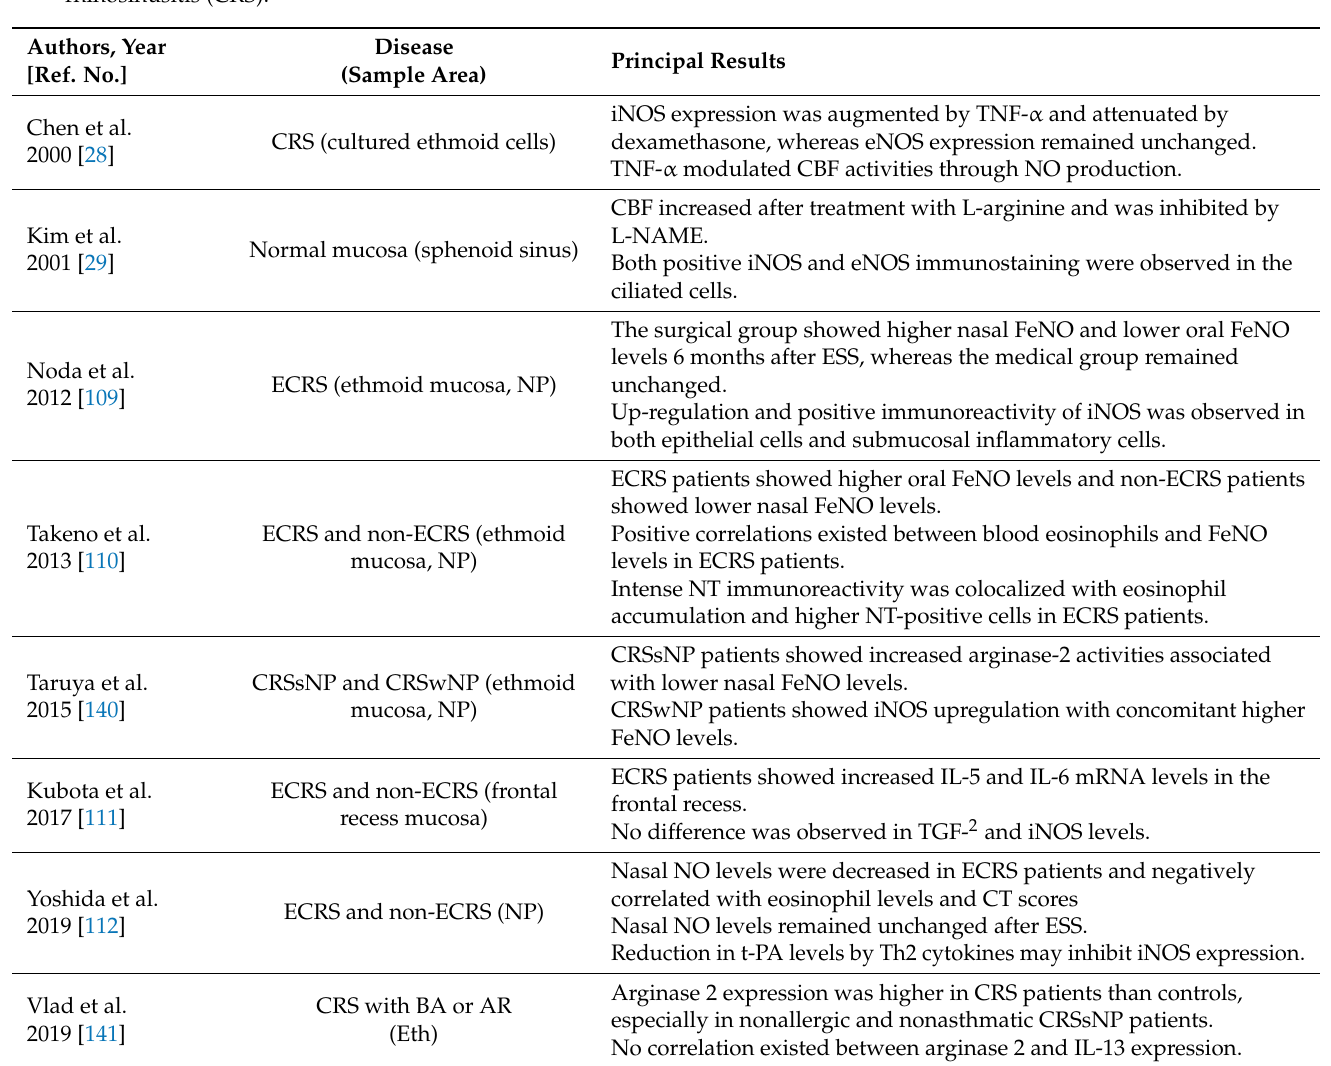
Table 2. Studies focusing on the expression and distribution of NOS isoforms and concomitant NO production in chronic rhinosinusitis